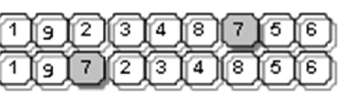
Figure 11. The IM procedure for selected gene 7 and position 3.